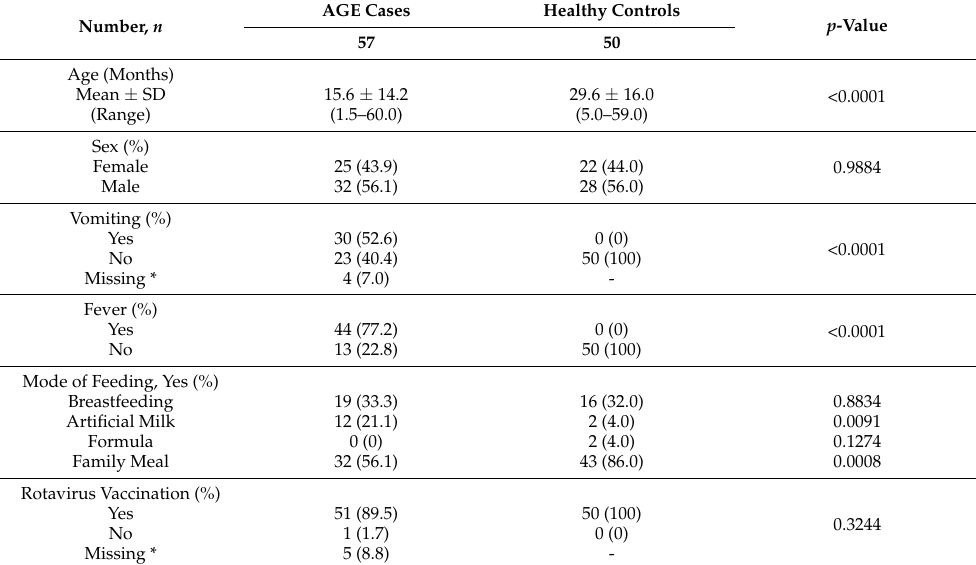
Table 1. Characteristics of study